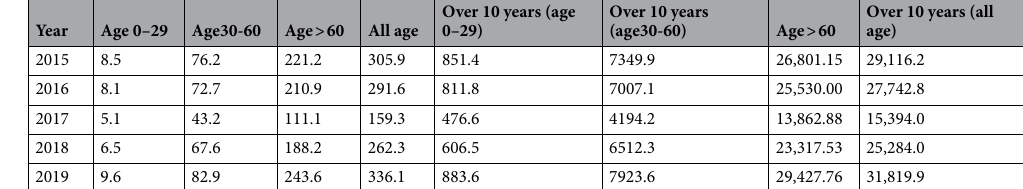
Table 2. The comparison of YLL because of deaths attributable to PM 2.5 in Ratchaburi province.